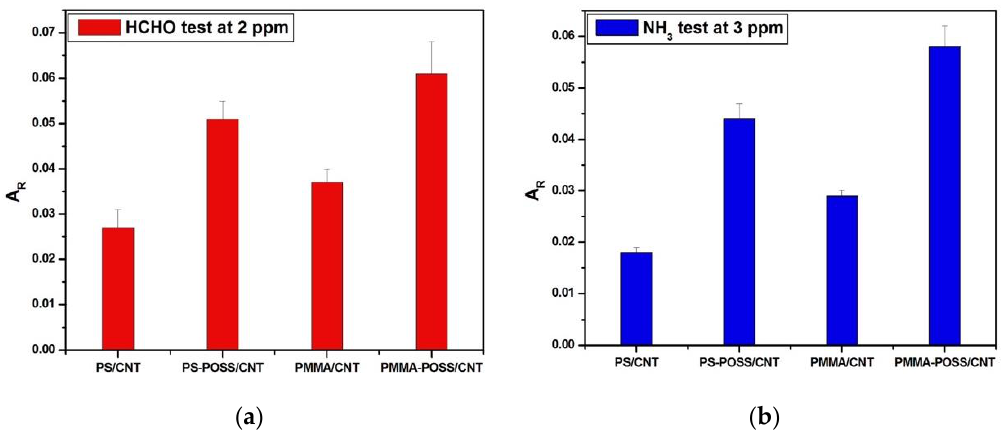
Figure 4. The effect of the presence of POSS co-monomer on the chemo-resistive responses of PS-CNT and PMMA-CNT sensors to ( a ) 2 ppm of CH 2 O vapour and ( b ) 3 ppm of NH 3 vapour.